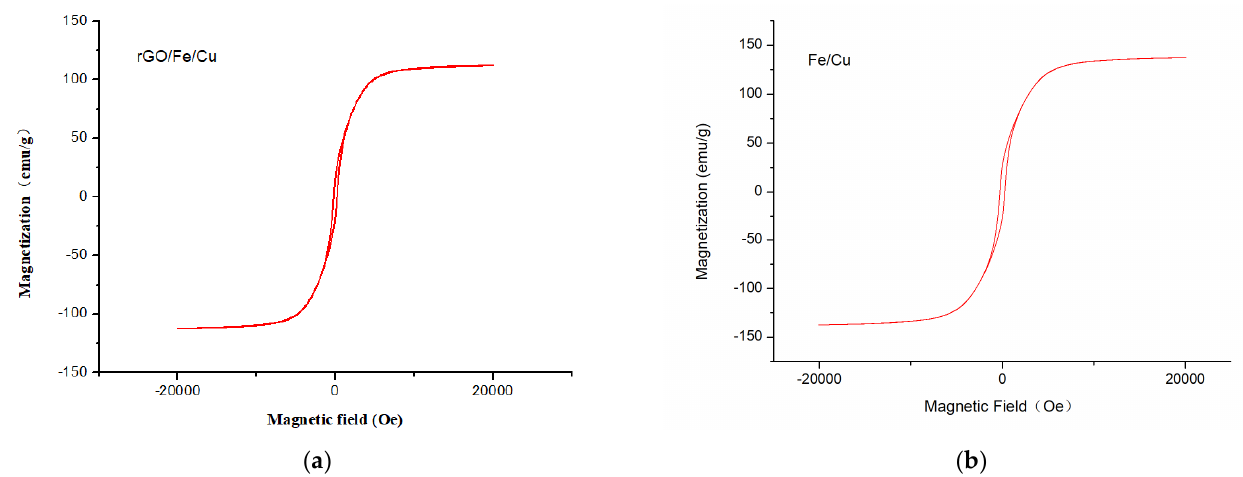
Figure 11. Raman spectra of rGO/Fe/Cu nanocompounds.